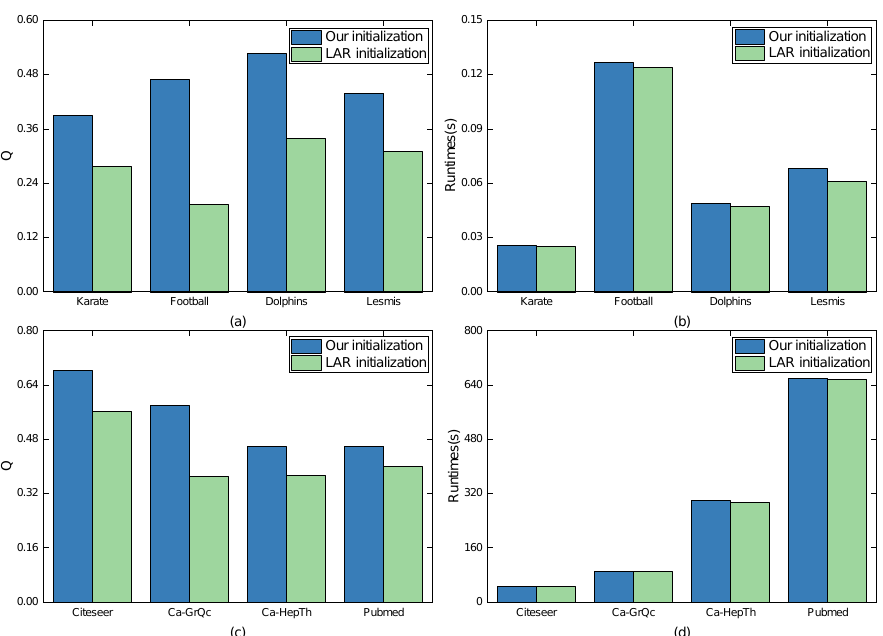
Figure 11. Comparison of different initialization methods. ( a ) Comparison of Q for four small datasets. ( b ) Comparison of time for four small datasets. ( c ) Comparison of Q for four big datasets. ( d ) Comparison of time for four big datasets.